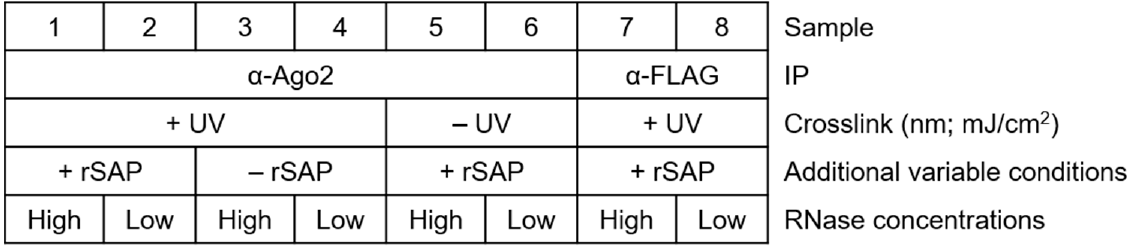
Table 7. RNA-Primer Mix for Reverse Transcription.